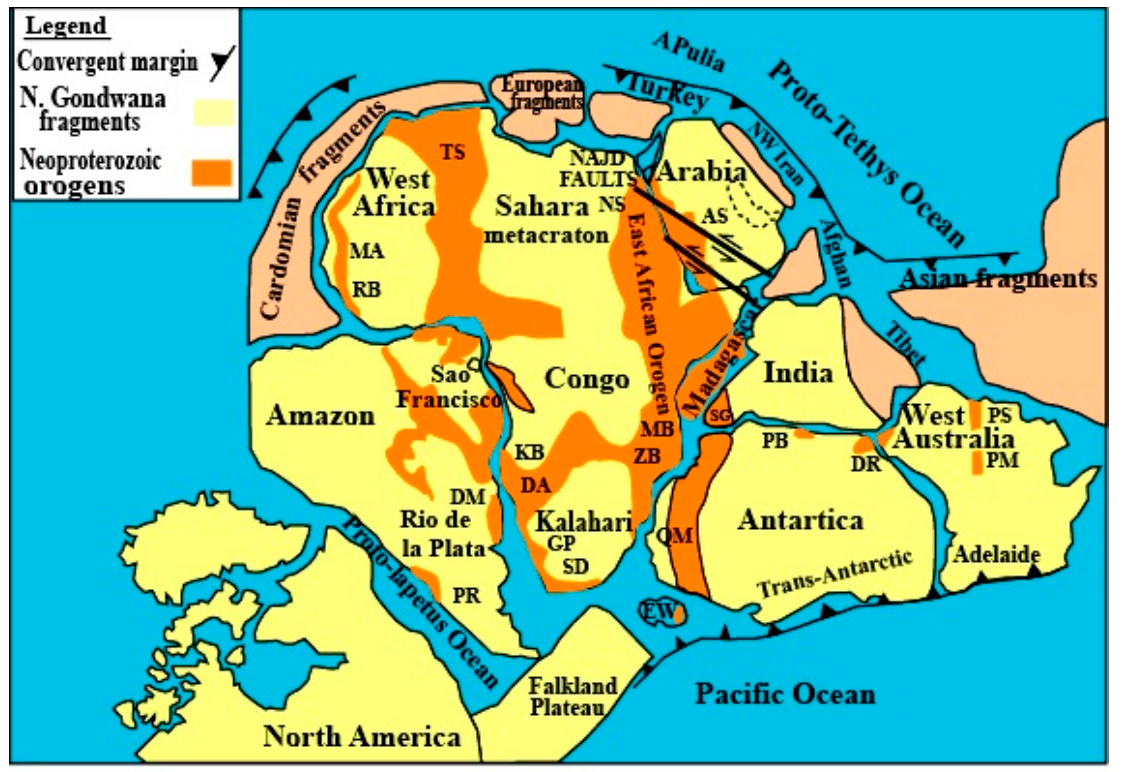
Figure 10. Map of Gondwana at the end of Neoproterozoic time (540 Ma) showing the general arrangement of PanAfrican belts. AS, Arabian Shield; BR, Brasiliano; DA, Darnara; DM, Dom Feliciano; DR, Denman Darling; EW, Ellsworth-Whitrnore Mountains; GP, Gariep; KB, Kaoko; MA, Mauretanides; MB, Mozarnbique Belt; NS, Nubian Shield; PM, Peterman Ranges; PB, Pryolz Bay; PR, Parnpean Ranges; PS, Paterson; QM, Queen Maud Land; RB, Rokelides; SD, Saldania; SG, Southern Granulite Terrane; TS, Trans-Sahara Belt; WB, West Congo; ZB, Zambezi. (Reproduced with permission from [140]).